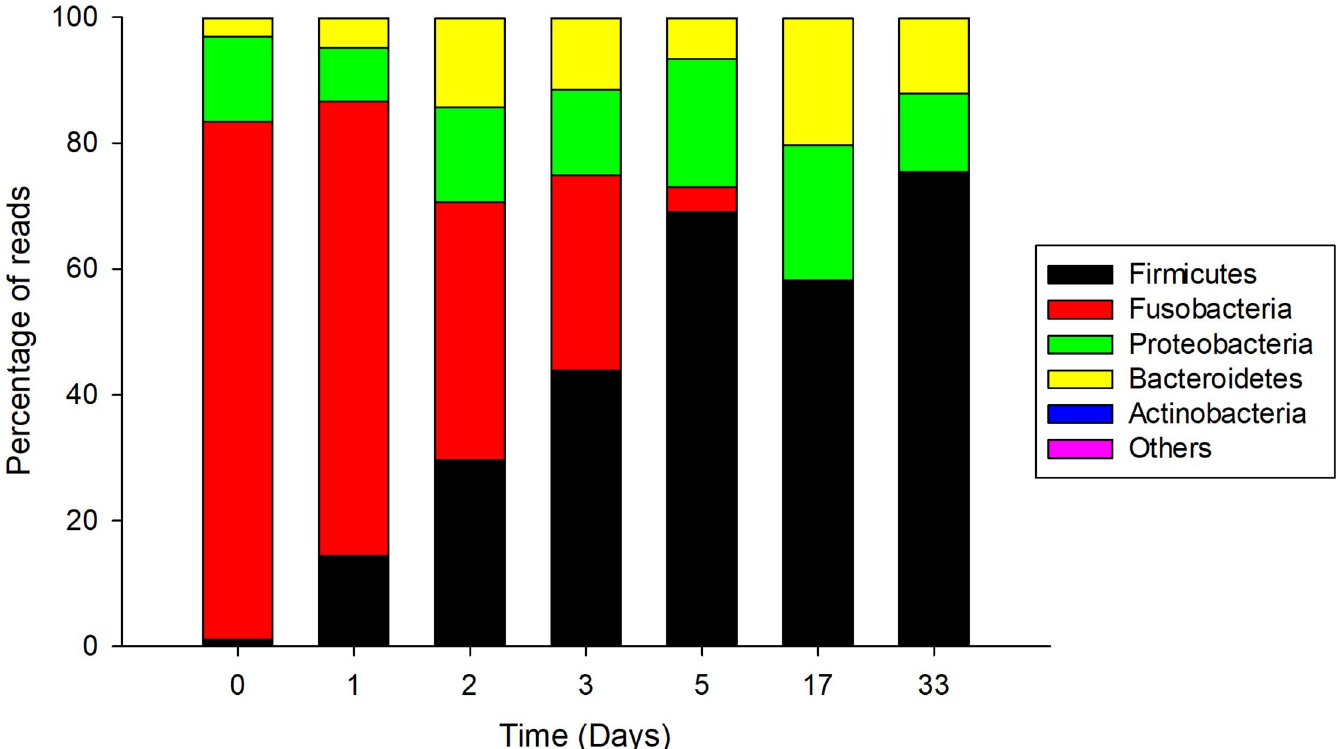
Fig 4. Relative abundance of intestinal bacteria phyla in a Nile tilapia ( Oreochromis niloticus )-derived continuous-flow competitive exclusion culture.